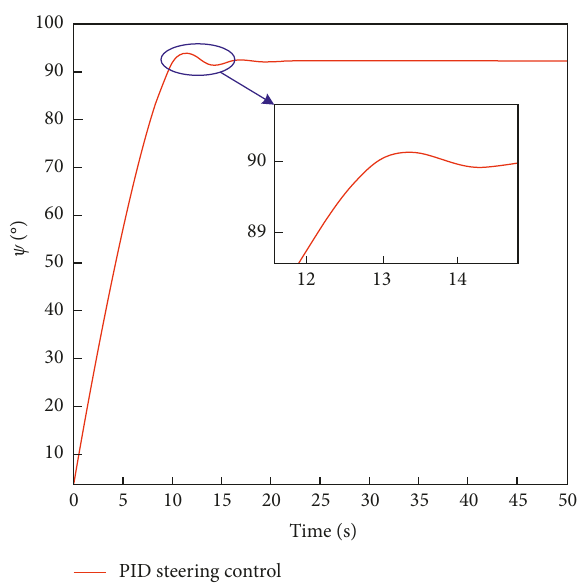
Figure 5: The PID steering control